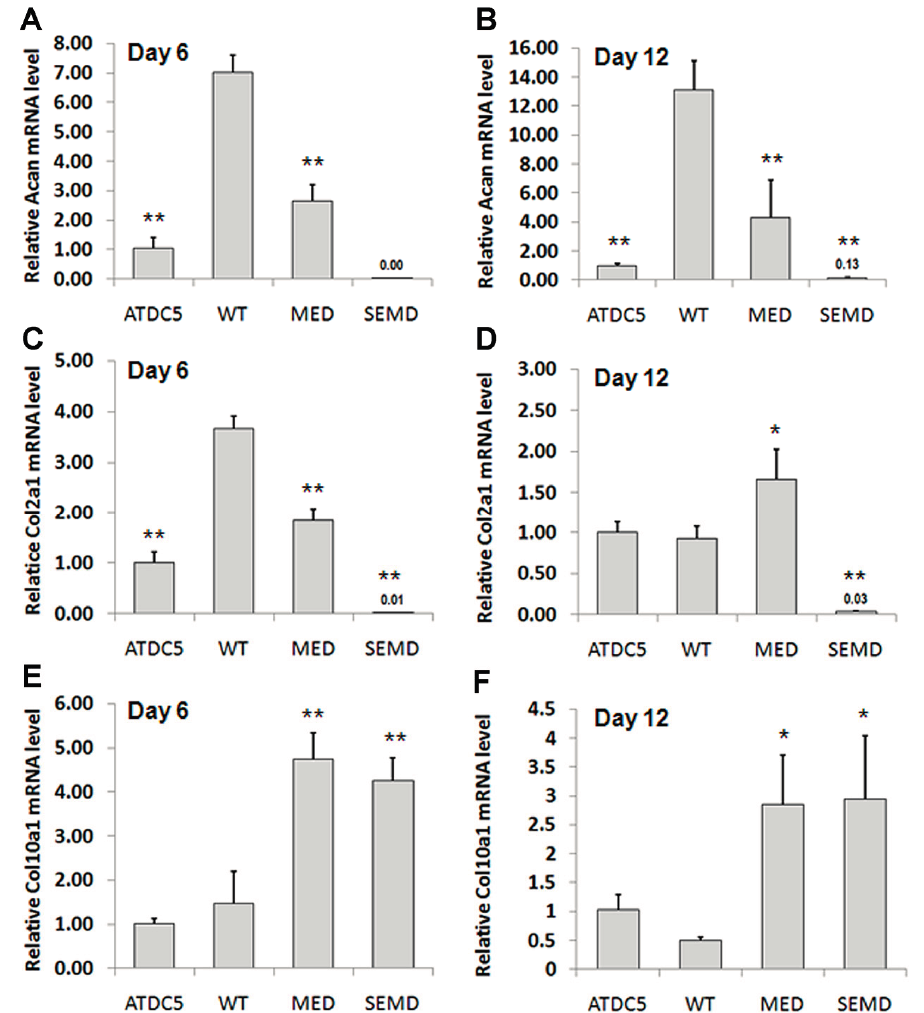
Figure 4. Chondrogenesis and hypertrophic marker expression in WT and mutant MATN3 transfected ATDC5 chondroprogenitors. ( A , B ) Aggrecan mRNA levels; ( C , D ) collagen II mRNA levels; ( E , F ) collagen X mRNA levels as analyzed by real time RT-PCR in untransfected and MATN3 transfected ATDC5 cells on days 6 and 12, respectively. * p ≤ 0.05 , ** p ≤ 0.01 vs . WT MATN3 stably transfected ATDC5